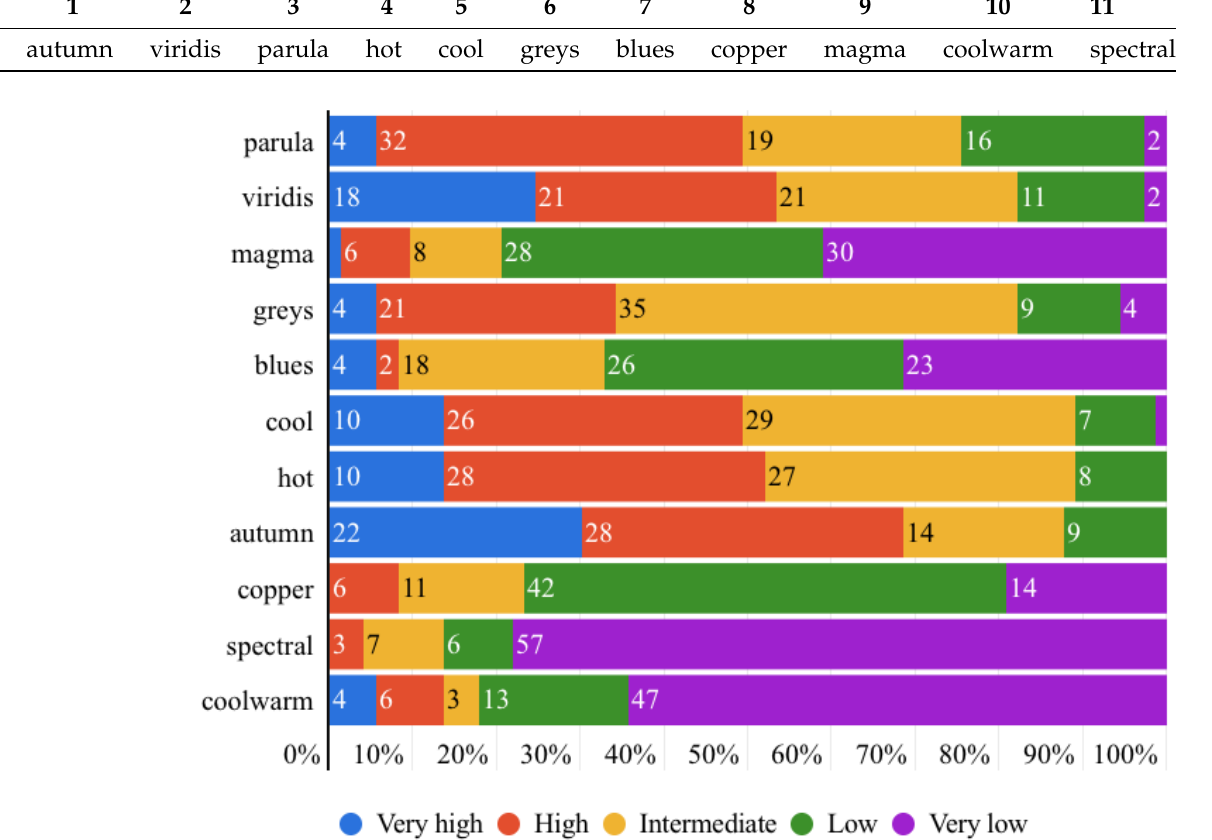
Figure 13. The overall accuracy rating results of the 11 colormaps by the 73 participants (rating scale: very high accuracy, high accuracy, intermediate accuracy, low accuracy and very low